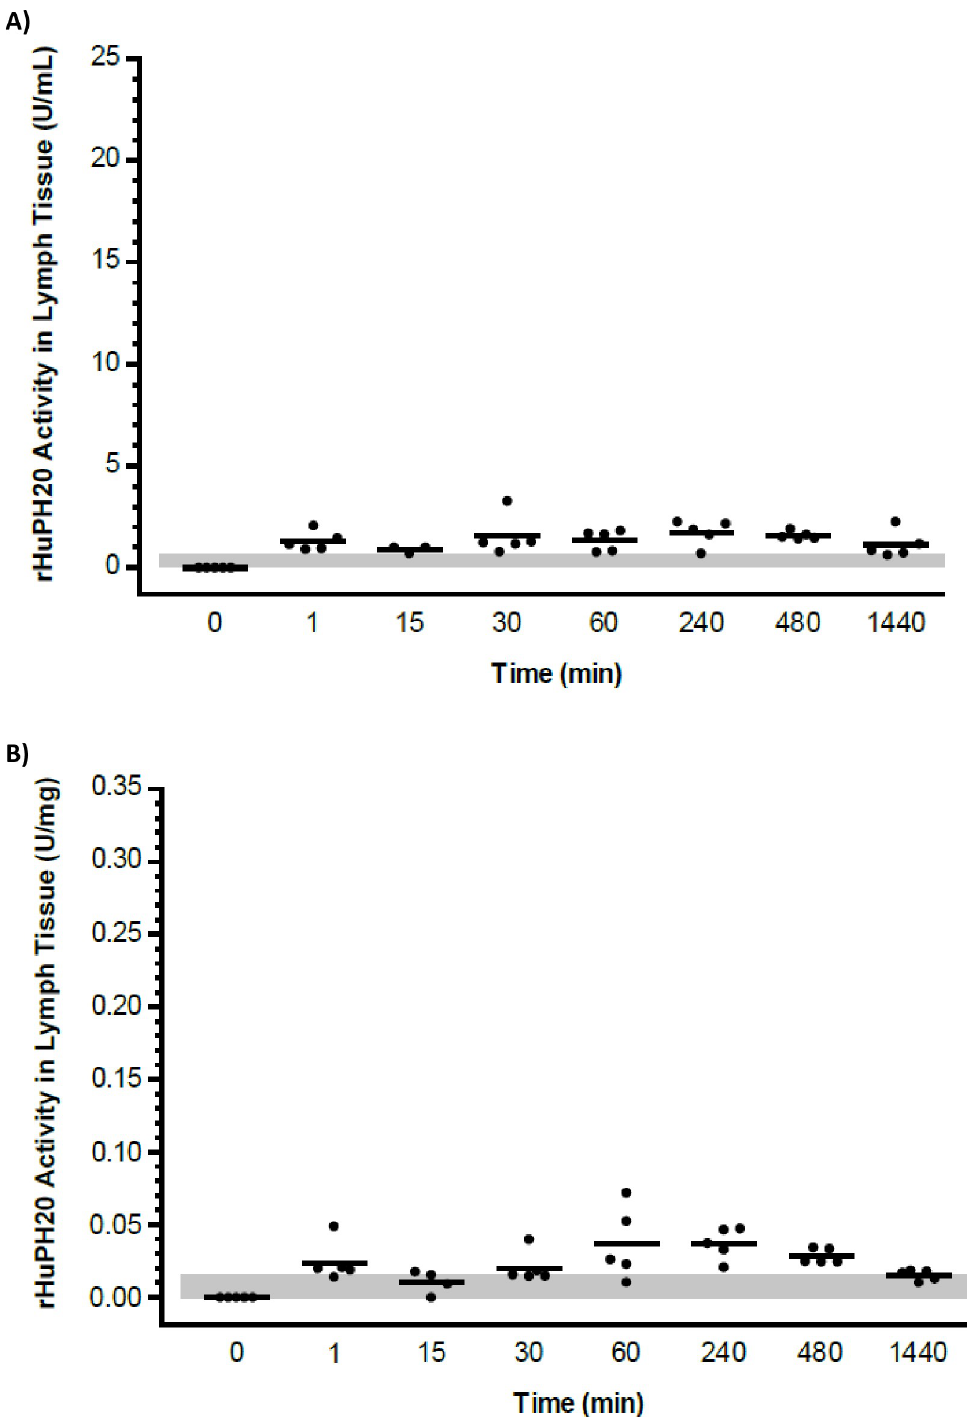
Fig 2. Biodistribution study: Concentration-time course of rHuPH20 in lymph samples after ID delivery. rHuPH20 concentration in lymph samples from individual animals (circles) are depicted as well as the mean (line) for each time point. (A) Concentrations in U/mL, LLOQ = 0.70 U/mL. (B) Concentrations in U/mg wet tissue weight, LLOQ = 0.02 U/mg. Values lower than the LLOQ (shaded area) are plotted as 0. ID, intradermal; LLOQ, lower limit of quantitation; rHuPH20, recombinant human hyaluronidase PH20.